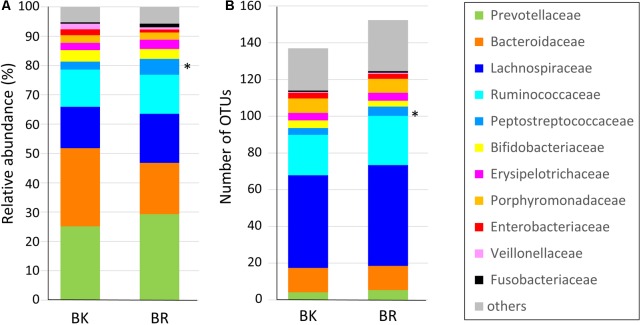
Composition of the fecal microbiota of children in Bangkok and Buriram. (A) Relative abundance of bacterial families. Average abundance of bacteria in 17 Bangkok (BK) and 28 Buriram (BR) children. (B) The average number of operational taxonomic units annotated to each family in 17 BK and 28 BR children. The asterisk at the right side of the bar indicates the bacterial family that was significantly more abundant in BR children than BK children (p < 0.05, Wilcoxon rank-sum test).